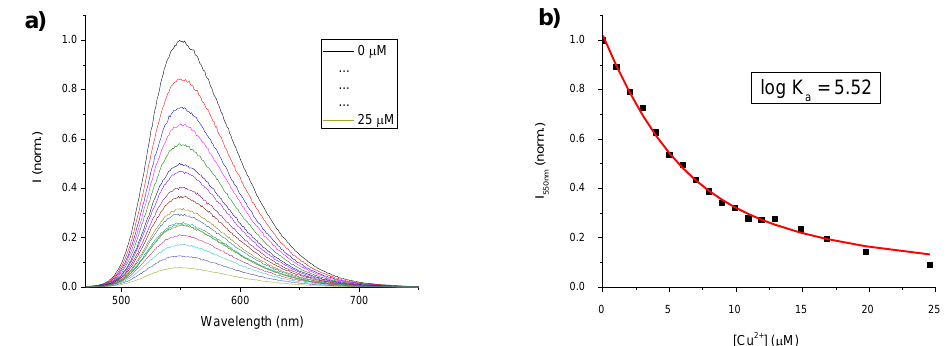
Figure 2. ( a ) Emission spectra from 4 in the presence of increasing amounts of Cu 2+ ; ( b ) Normalized emission changes in 4 upon addition of Cu 2+ (black dots) and respective exponential fitting (red line). Conditions: [ 4 ] = 5.0 µM; pH 7.0 ± 0.2 buffered with 10 mM HEPES; T = 298 K; λ exc = 458 nm.